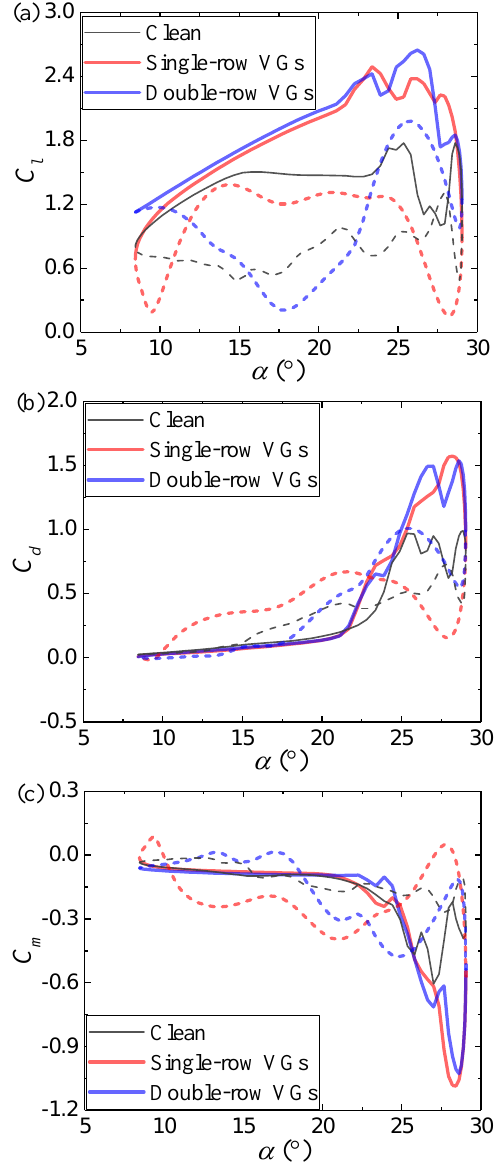
Figure 6. Aerodynamic hysteresis loops of the NREL S809 airfoil with and without VGs. Solid lines denote increasing angles of attack (AOA), and dashed lines indicate decreasing AOA. ( a ) C l ; ( b ) C d ; ( c ) C m .